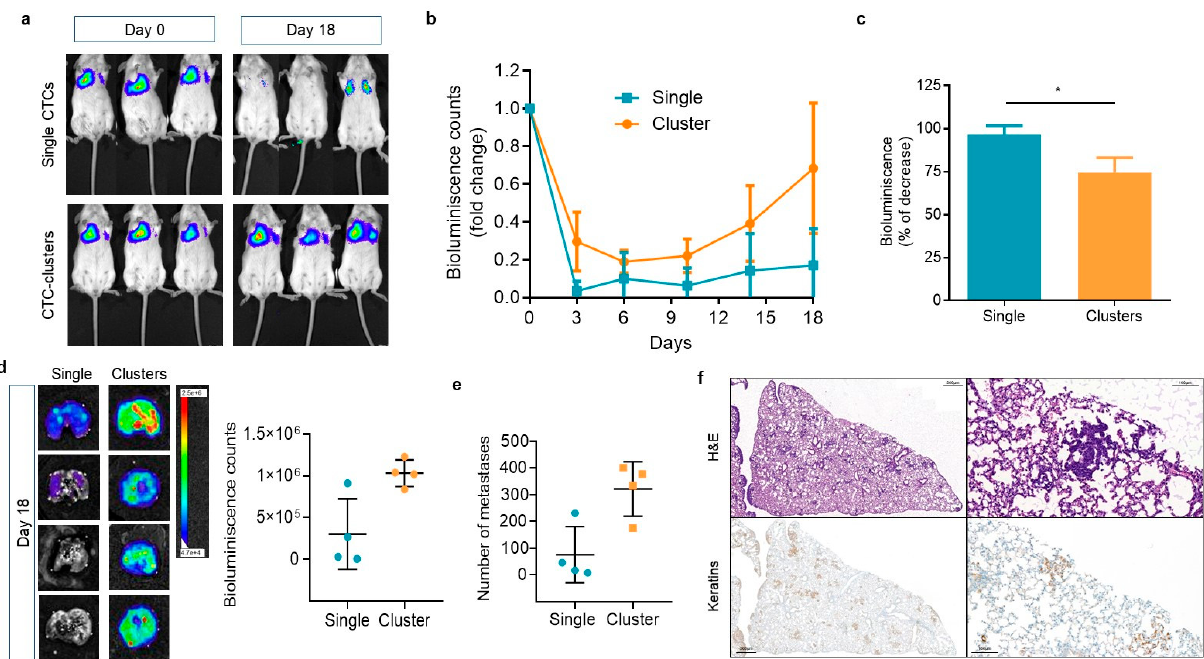
Figure 4. Assessing metastatic colonization ability of single and cluster models in the mouse. ( a ) Representative images of the development of lung metastatic lesions over time in mice injected in the lateral tail vein with single CTCs or CTC-clusters assessed by measuring the bioluminescence signal (counts); ( b ) Bioluminescence signal throughout time emitted by the tumor cells that has colonized the pulmonary tissue ( n = 4 per group); ( c ) Percentage of decrease of the bioluminescence signal in the lung of mice 3 days after tail vein injection of single and cluster populations (* p < 0.05); ( d ) Representative pictures of the bioluminescence signal measured in the surgically removed lungs of mice injected with single CTC or CTC-cluster models, and quantification of the bioluminescence signal; ( e ) Quantification of the number of metastatic foci in the lungs of mice injected with single CTCs or CTC-clusters; ( f ) Representative images of lungs with metastases, visualized with Hematoxin-eosin (H&E, upper panels), and sections of the lung stained with an antibody for keratins (bottom panels). Note the brown staining in tumor clusters and nodules. Left images are shown at a low magnification ( × 5; scale bar 500 µ m), and right images at a high magnification ( × 20; scale bar 1000 µ m).